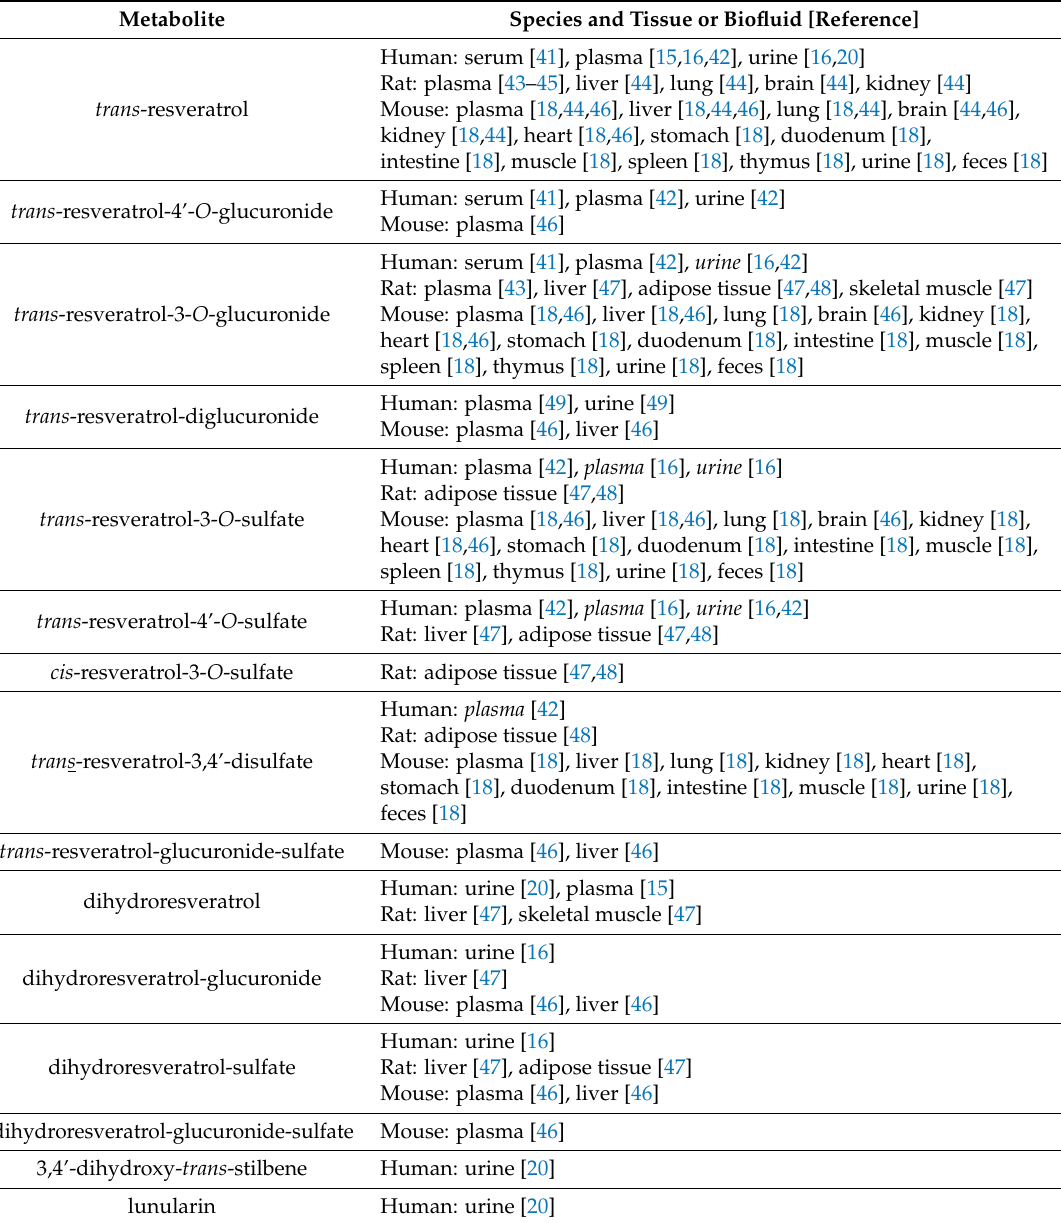
Table 1. Human, rat, and mouse resveratrol metabolites after oral administration in different biofluids and tissues (see structures in Figure